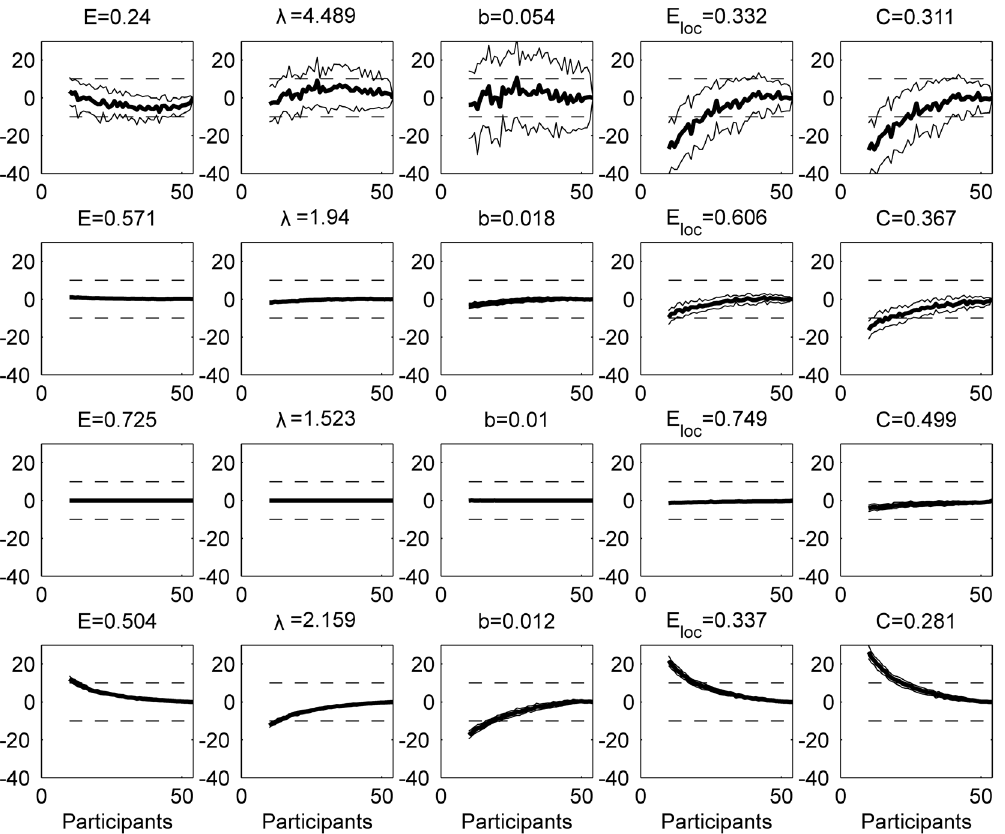
Fig. 5. Group size effect for group based networks. The effect of group size for networks at a density of 5% (top row), 20% (second row), 45% (third row) and the weighted network (bottom row). A bootstrapping procedure was used (100 realizations) to randomly group the subjects with increasing group size. For graph measures the relative change (%) to the reference value (which is obtained when taking the complete group) are shown. Full lines denote the mean (bold) and + standard deviation of the metric. Dotted lines represent a relative change of + 10%. E : global efficiency; l : the characteristic path length; b : the mean betweenness centrality; E loc : the mean local efficiency and C : the mean clustering coefficient.